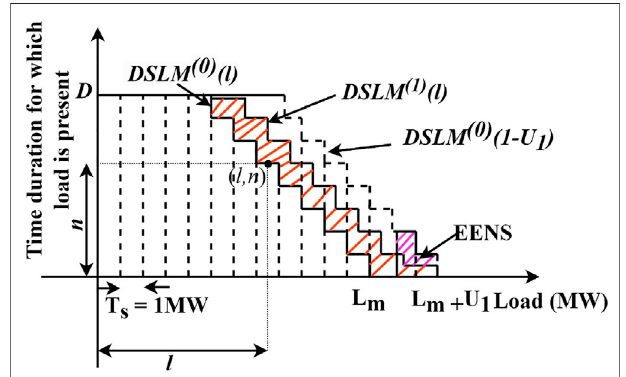
FIGURE 5 | DSLM incorporating random outage of a generator.